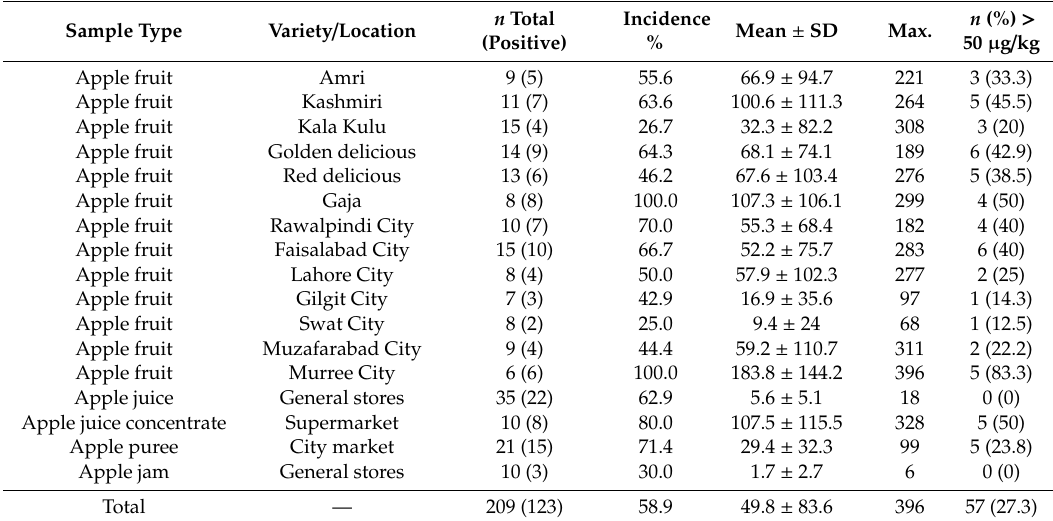
Table 1. Occurrence of patulin ( µ g / kg) in apple fruits and their derived